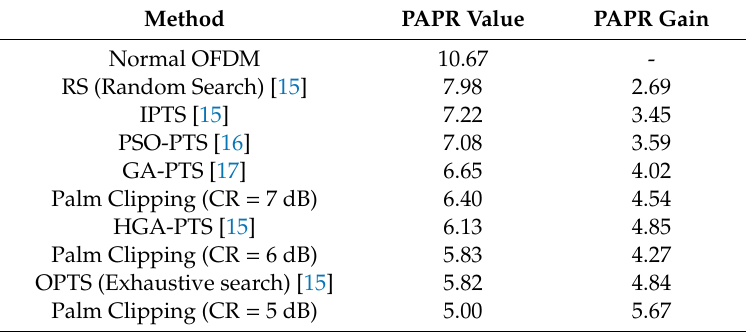
Figure 19. CCDF at 10 − 3 of the PC method with a CR of 5, 6, and 7 dB compared with Partial Transmit Sequences (PTS) and its variants, where w = 4 and v = 8, N = 64, with the 16-QAM modulation. Table 4. PAPR comparison at CCDF = 10 − 3 of Palm Clipping with Partial Transmit Sequence (PTS) variants with w = 4 and v = 8. IPTS: Iterative flipping PTS, PSO-PTS: Particle Swarm Optimization Partial Transmit Sequences, GA-PTS: Genetic Algorithm Partial Transmit Sequences, HGA-PTS: Hybrid Genetic Algorithm PTS, OPTS: Optimal